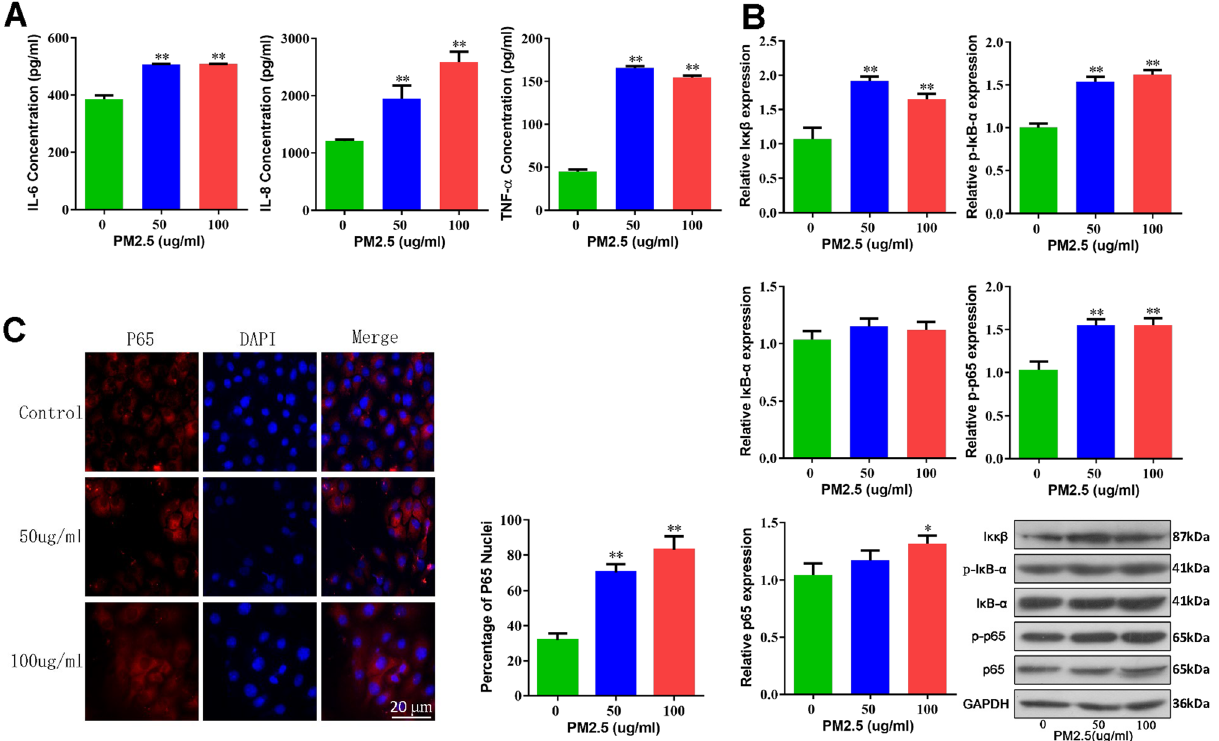
Figure 1. Effects of TRAPM2.5 on the inflammatory response of human bronchial epithelial cells. ( A ) ELISAs analysis of IL-6, IL-8, and TNF-α levels in HBECs treated with 0, 50, and 100 μg/ml TRAPM2.5 for 48 h. ( B ) Western blotting analysis of Iκκβ, p-IκB-α, IκB-α, p-p65 and p65 in HBECs treated with 0, 50, and 100 μg/ml TRAPM2.5 for 48 h. GAPDH was used as an internal control. ( C ) Immunofluorescence microscopy